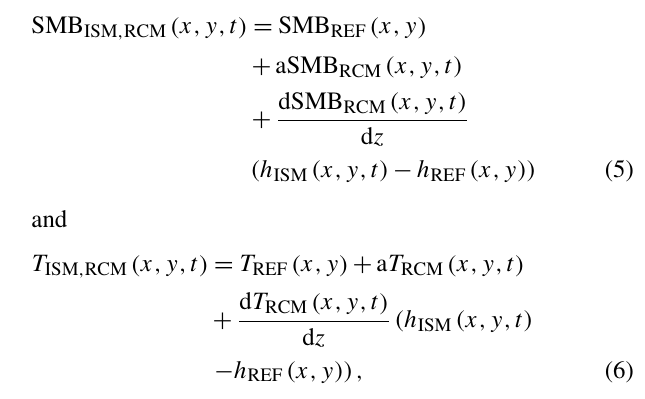
period (e.g., Fettweis et al., 2017; Mouginot et al., 2019).